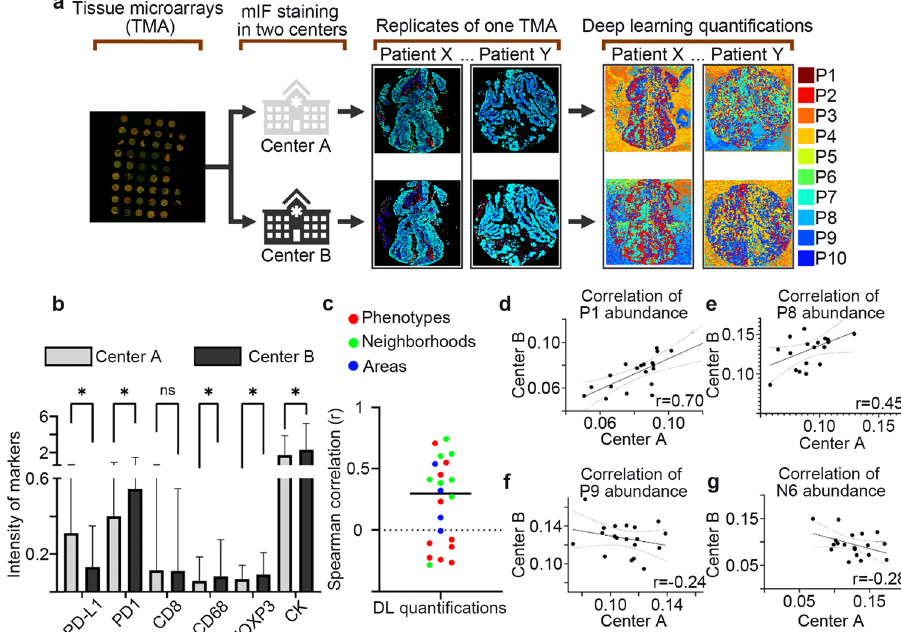
Fig. 7 NaroNet robustness. a Multiplexed immuno fl uorescence staining on tissue microarrays (TMAs) was performed in two different centers using a standardized and validated protocol. Nine TMAs were stained at the University of Navarra, and fi ve TMAs were stained at Lunaphore Technologies. To obtain a reference for variability between cases, one TMA with 36 tumor cores from 19 patients was stained in both institutions. In the replicate cores, deep learning quanti fi cations were performed. b In the replicate cores, intensity measurements for each marker were then calculated. No threshold normalization was applied to adjust for potential batch-to-batch variation. As expected, the intensity variation is found across centers. c The overall quanti fi cation of the relevant local phenotypes, cellular neighborhoods, and tissue areas showed good correlations. d , e Relevant elements, such as local phenotypes P1 and P8, showed positive correlations across institutions. f , g Negative correlations were found only for the microenvironmental elements located in regions with no tissue (background staining), such